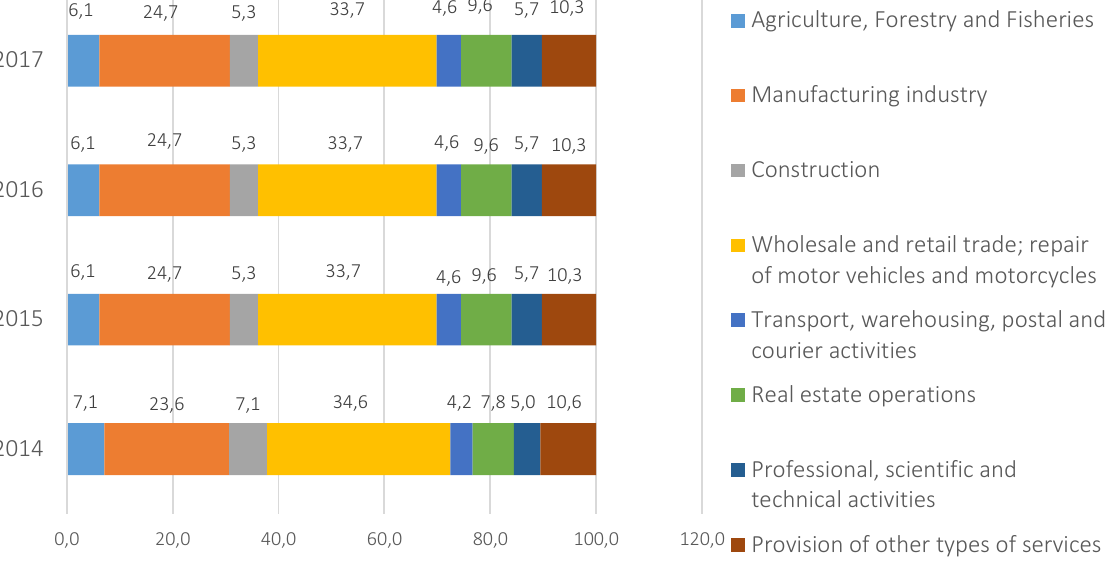
Figure 2. The structure of loans to non-financial corporations for 2014–2017 by types of economic activity,